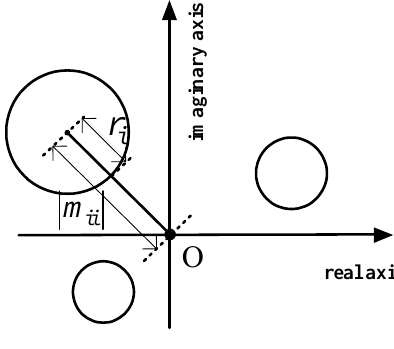
Figure 1. Schematic of Theorem 1.